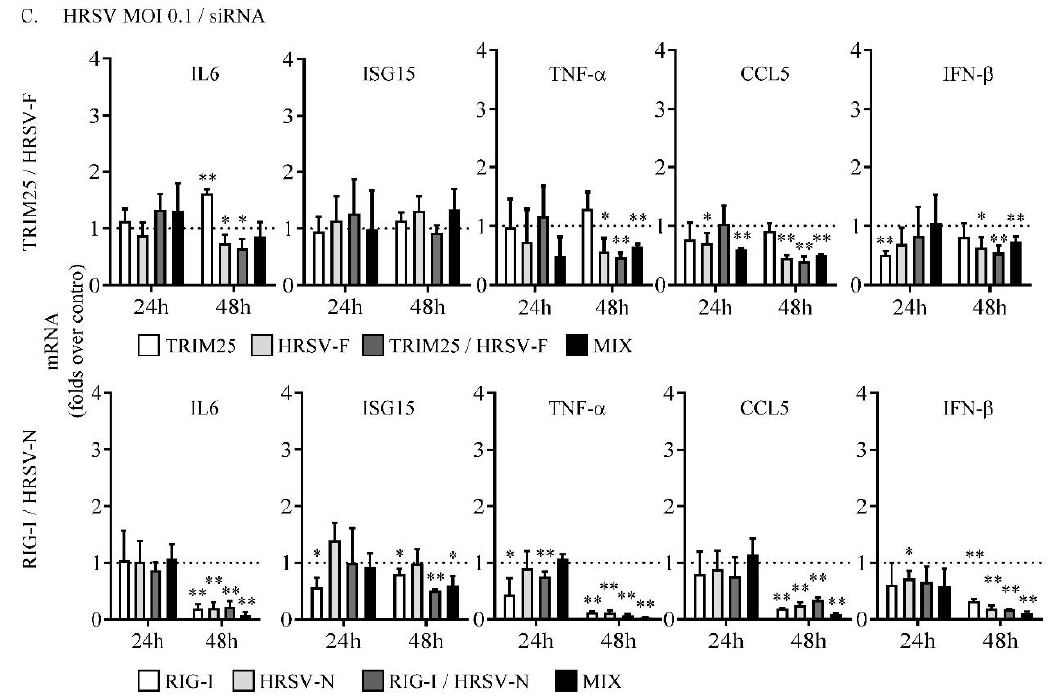
Figure 5. Relative levels of mRNAs from genes involved in the antiviral immune response in cells transfected with the different siRNAs. ( A ) Cells were transfected with the indicated siRNAs and infected 24 h later at a MOI of 3. ( B ) Cells were infected at a MOI of 3 and transfected 8 h later with the indicated siRNAs. ( C ) Cells were infected at a MOI of 0.1 and transfected 8 h later with the indicated siRNAs. Transfection/infection were done as in Figure 2. Levels of mRNAs were quantified by qRT-PCR at 24 and 48 hpi and represented as fold over mRNAs expressed in cells transfected with a control siRNA. Data represent the mean and standard deviation from three independent experiments. Comparisons between groups were done by using the t- test: *, p < 0.05 and **, p < 0.01.